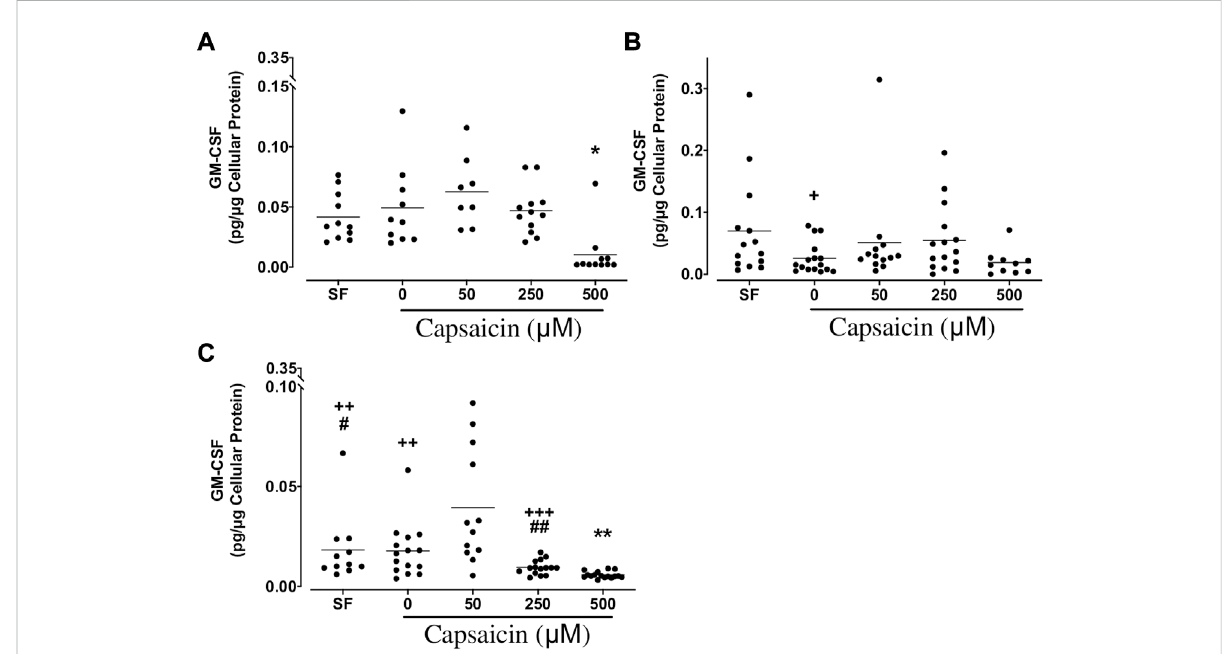
FIGURE 4 Effect of capsaicin on the release of granulocyte macrophage-colony stimulating factor (GM-CSF) of bronchial epithelial cells from non- smokers (A) , smokers (B) and patients with COPD (C) . Individual data points with means were displayed for non-smokers, smokers and patients